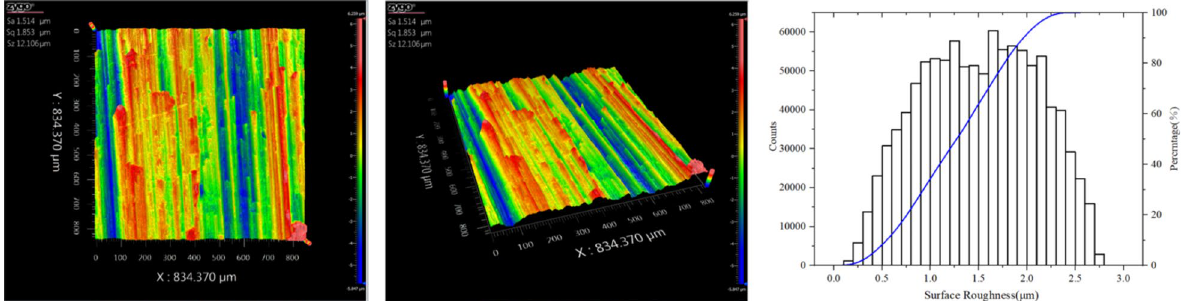
Figure 7 ( f 0.2 mm/r, v 260 m/min) 3D morphology, 2D morphology and roughness distribution curve of machined = =